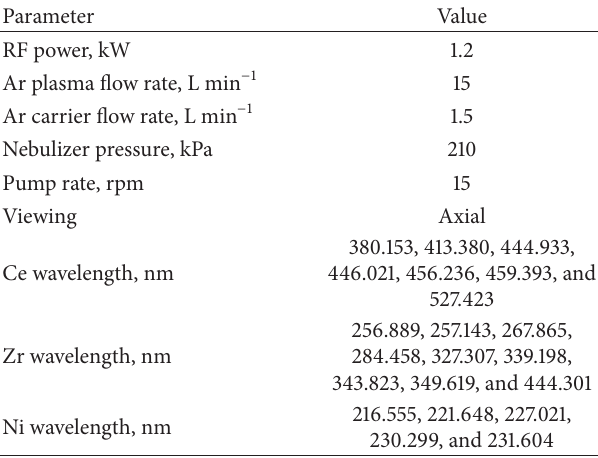
Table 1: The operating parameters of ICP-AES